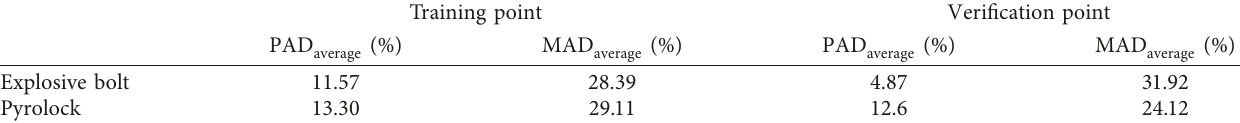
Table 5: Simulation similarity result between the real pyroshock and the simulated pyroshock for each experiment. Training point